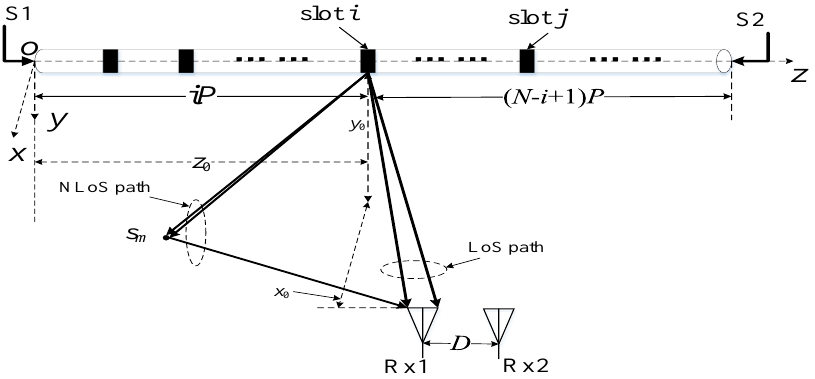
Figure 4. MIMO system with single double-port fed LCX considering both LoS and NLoS paths. According to formulas (4) – (8), the CIR expressions of the LoS path and NLoS path from the input signals S1 and S2 of double-port fed LCX at transmitter (Tx) to first receiv-